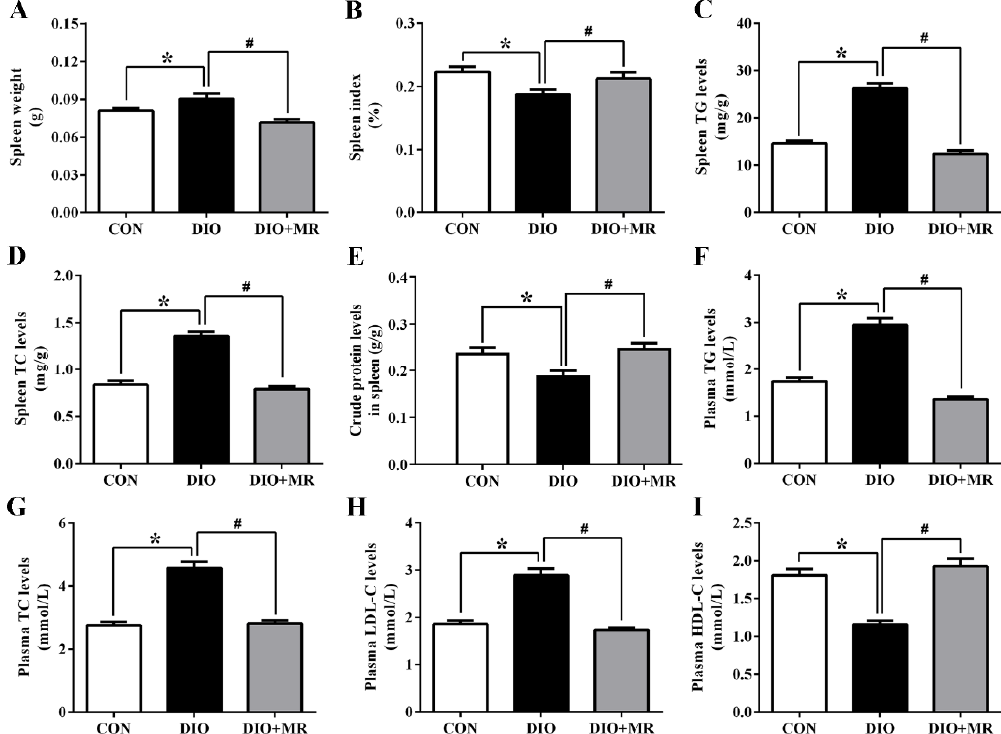
Figure 3. Effects of MR on spleen weight ( A ), spleen index ( B ), spleen TG levels ( C ), spleen TC levels ( D ), splenic crude protein levels ( E ), plasma TG levels ( F ), plasma TC levels ( G ), plasma LDL-C levels ( H ), and plasma HDL-C levels ( I ) in obese mice. TG, triglyceride; TC, total cholesterol; LDL-C, low-density lipoprotein cholesterol; HDL-C, high-density lipoprotein cholesterol. All data are shown as mean ± SEM ( n = 10). * p < 0.05 versus CON; # p < 0.05 versus DIO.